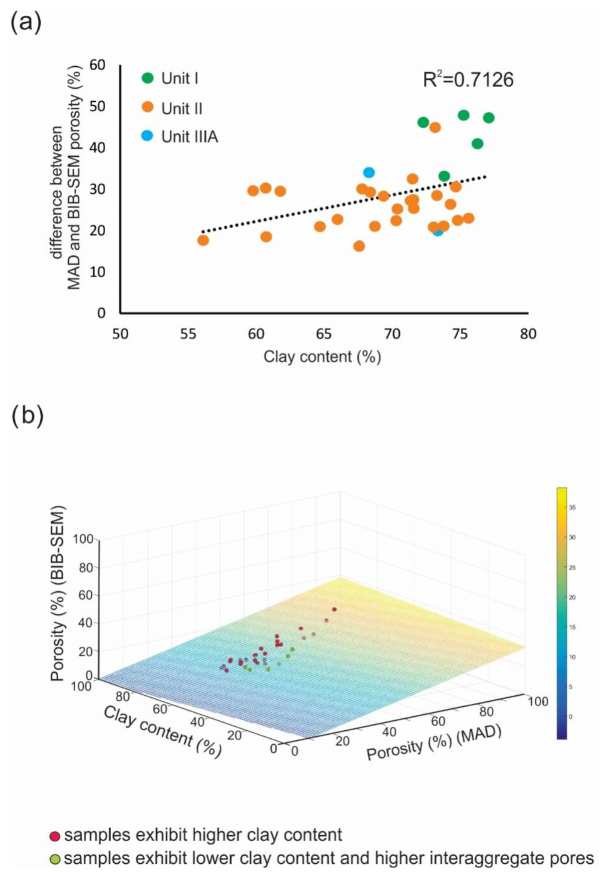
Figure 12. (a) Clay content vs. the difference between MAD and BIB–SEM porosity. Green, orange, and blue symbols represent the samples from Units I, II, and III, respectively. (b) Multivariate re- gression analysis using three parameters: BIB–SEM porosity, clay content, and MAD porosity (33